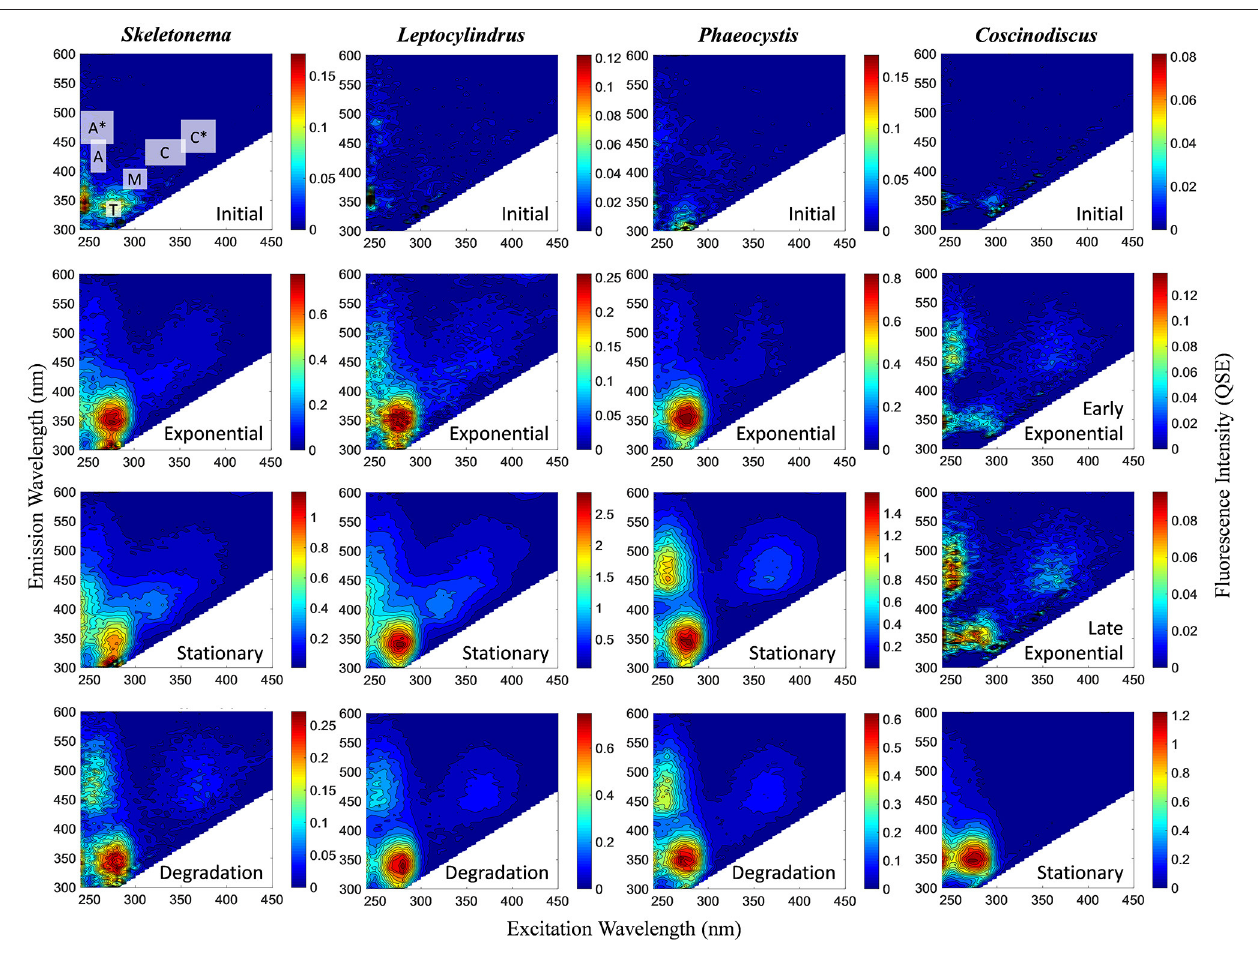
FIGURE 1 | Representative excitation-emission matrices (EEMs) of BEPOM fluorescence for genera Skeletonema , Leptocylindrus , and Phaeocystis at initial, exponential, stationary, and degradation phases and for Coscinodiscus sp. at initial, early exponential, late exponential, and stationary growth phases. Color bars are presented in quinine sulfate equivalence (QSE) where 1 QSE = 1 ppb quinine sulfate equivalents. Note different scales for color bars for each EEM. Major peak regions of EEMs are indicated in the initial time point for Skeletonema sp.